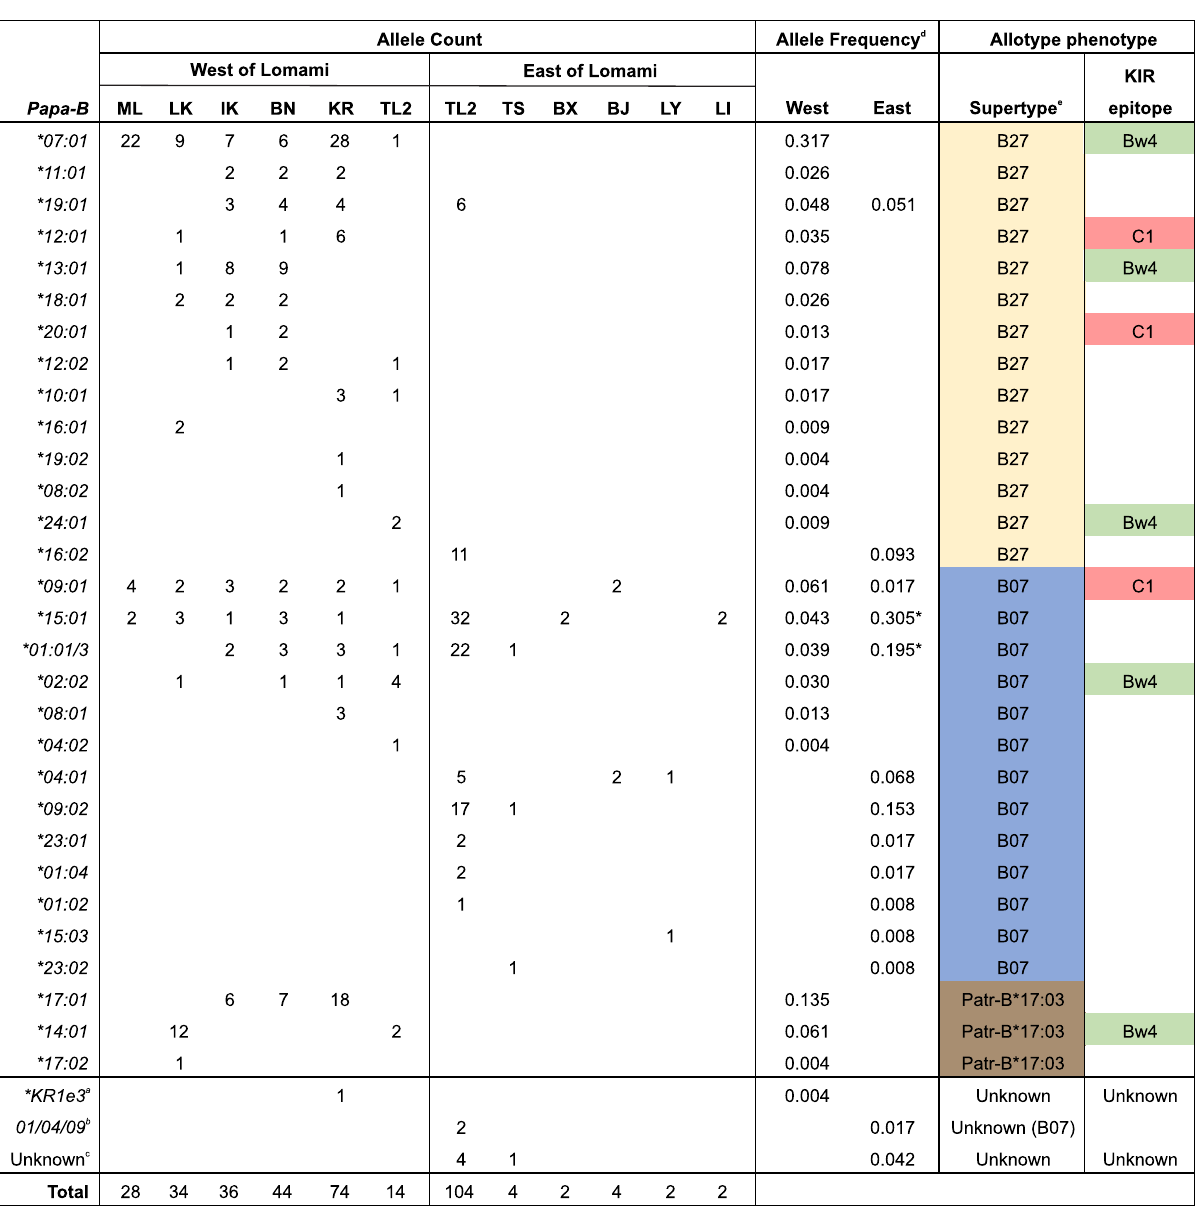
Fig. 2 | Papa-B allele counts, frequencies, and allotype phenotypes at 12 study sites. For each Papa-B allele, it is noted which peptide-binding supertype that it possesses (B27 (yellow), B07 (blue), Patr-B*17:03 (17:03, brown), and whether or not it encodes a KIR epitope (either Bw4 (green) or C1 (red)). a KIR epitope and supertype are “ Unknown. ” b Genotyping resolved the second allele as being one of threealleles( Papa-B * 01:02,04:01,09:02 ),allof whichhavetheB07supertypeand